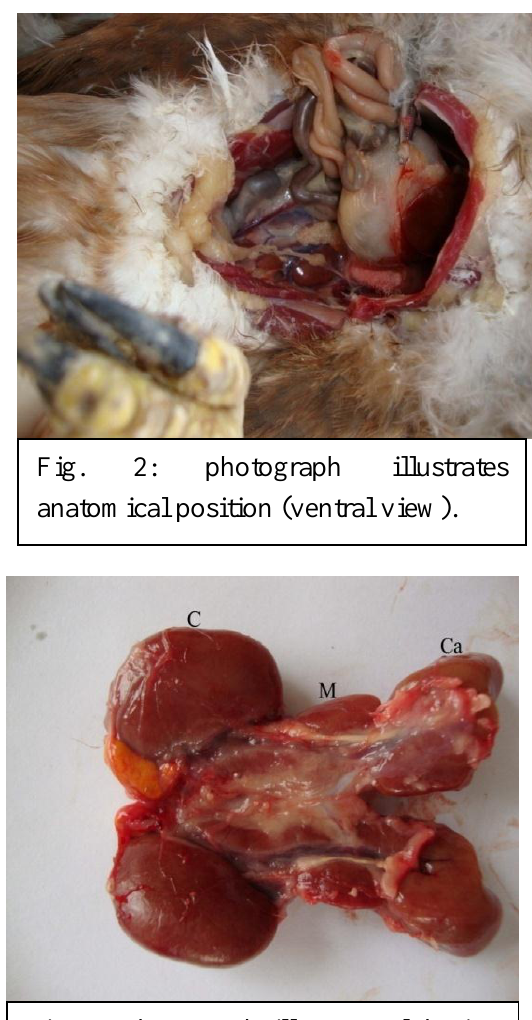
Fig. 4: photograph illustrates lobation kidney (visceral surface).C. cranial, M. middle and Ca. caudal lobe.